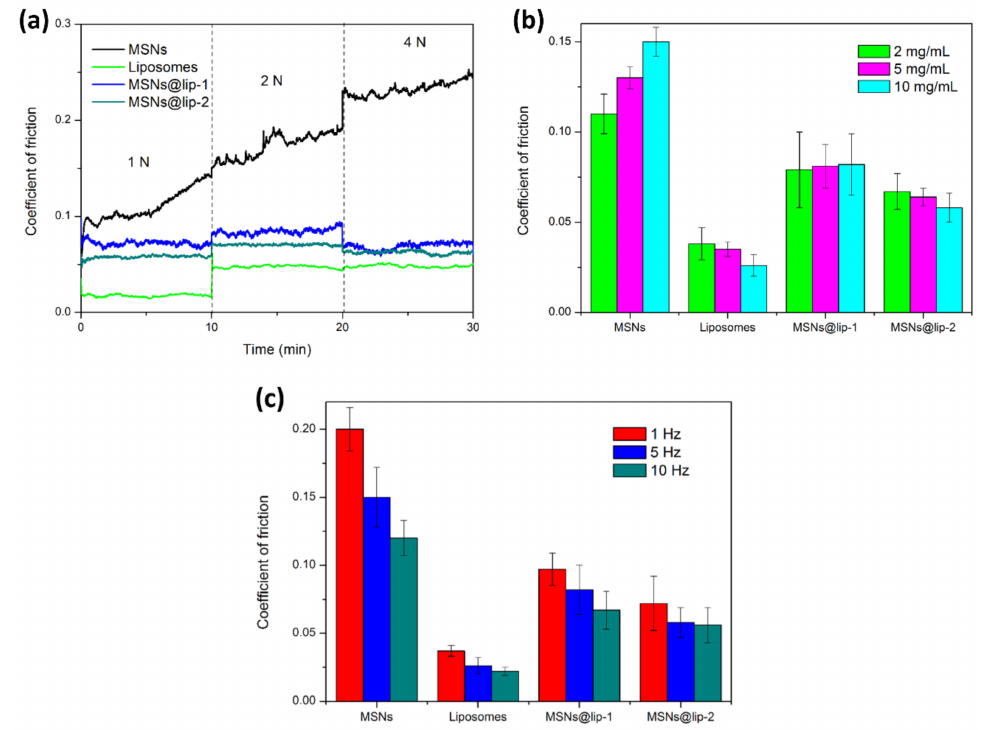
Figure 4. The lubrication property of MSNs, DSPC liposomes, MSNs@lip-1 and MSNs@lip-2 in aqueous suspension evaluated by a series of tribological tests under different conditions: ( a ) friction coefficient-time plots under applied gradient load; ( b ) comparison of the friction coefficient for the nanoparticles at different concentrations; ( c ) comparison of the friction coefficient for the nanoparticles under different reciprocating